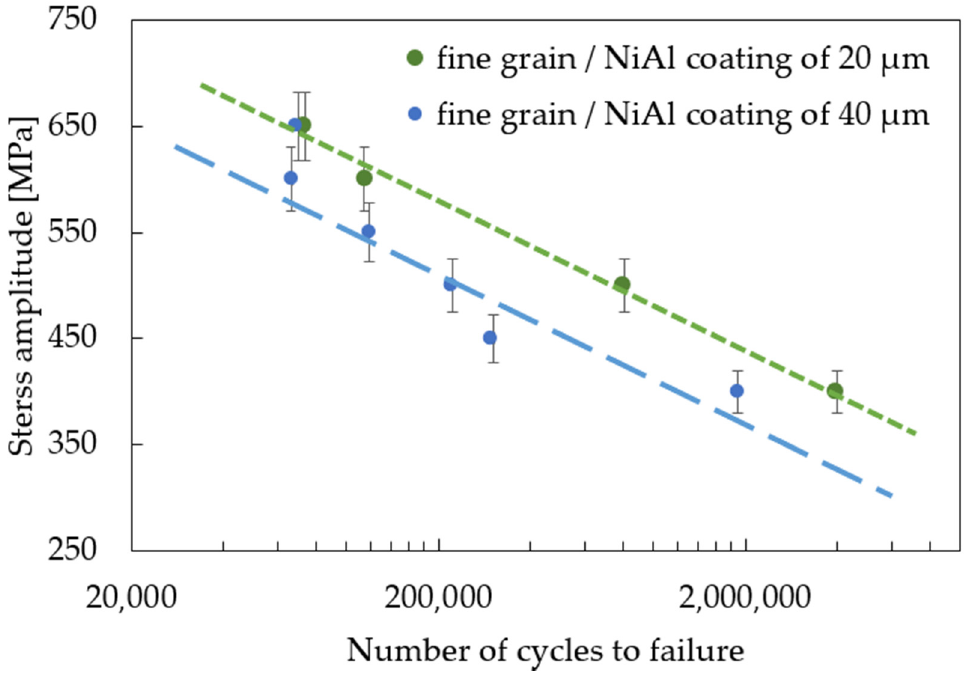
Figure 6. S-N curves for the coated, fine-grained MAR 247 nickel-based superalloy.